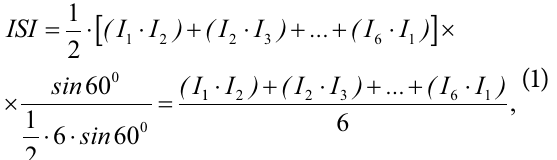
Table 1. Elements of the integral index of business environment security